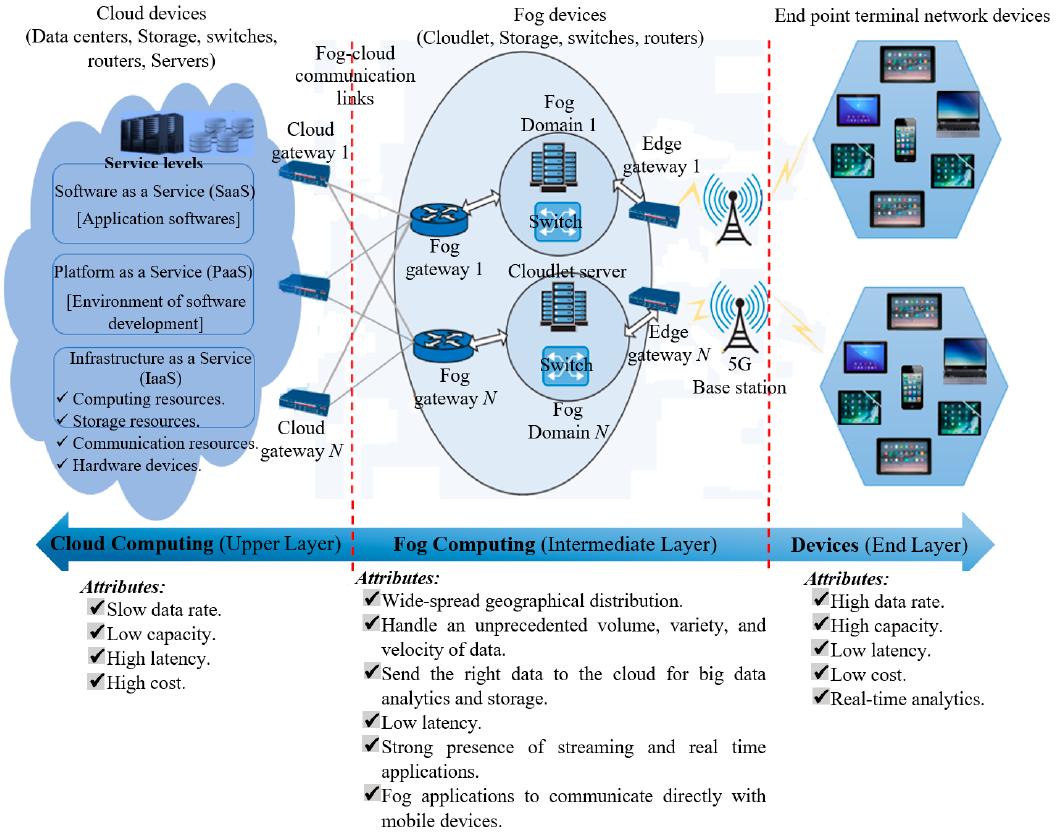
Figure 6. Fog computing and integration with the CC and devices layer.